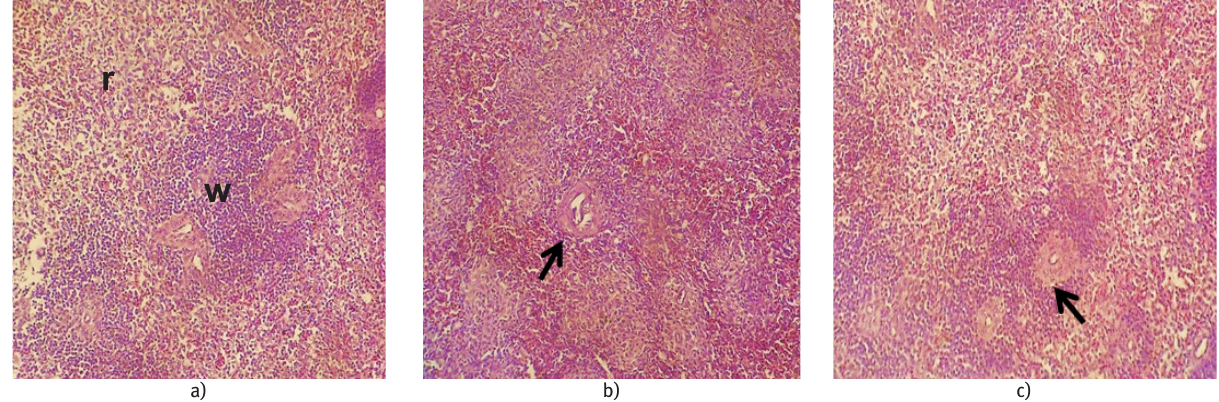
Figure 5: Photomicrograph of section of spleen of pigeons post-inoculation and/or exposure to a very virulent infectious bursal disease virus. Note intact white (w) and red (r) pulps in uninoculated pigeon (a), slight depletion of white pulp (arrows) in inoculated (b) and sentinel (c) pigeons. H & E x